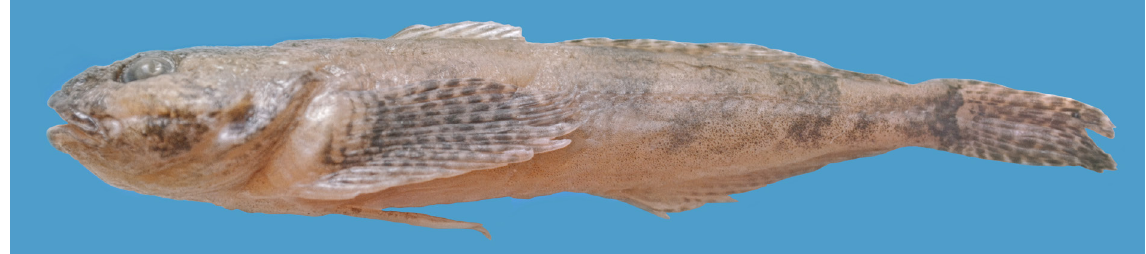
Fig. 7 . Cottus microstomus Heckel, 1837 (ZIN 56723), SL 78.4 mm, Siesartis River, Neman/Nemunas River basin